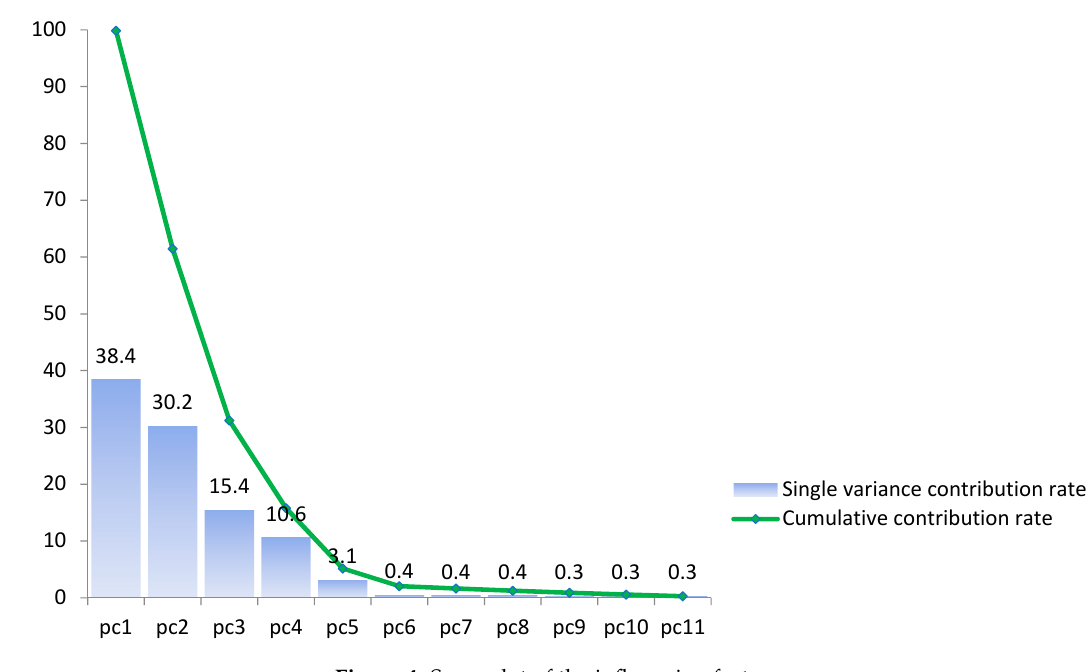
Figure 4. Scree plot of the influencing factors.